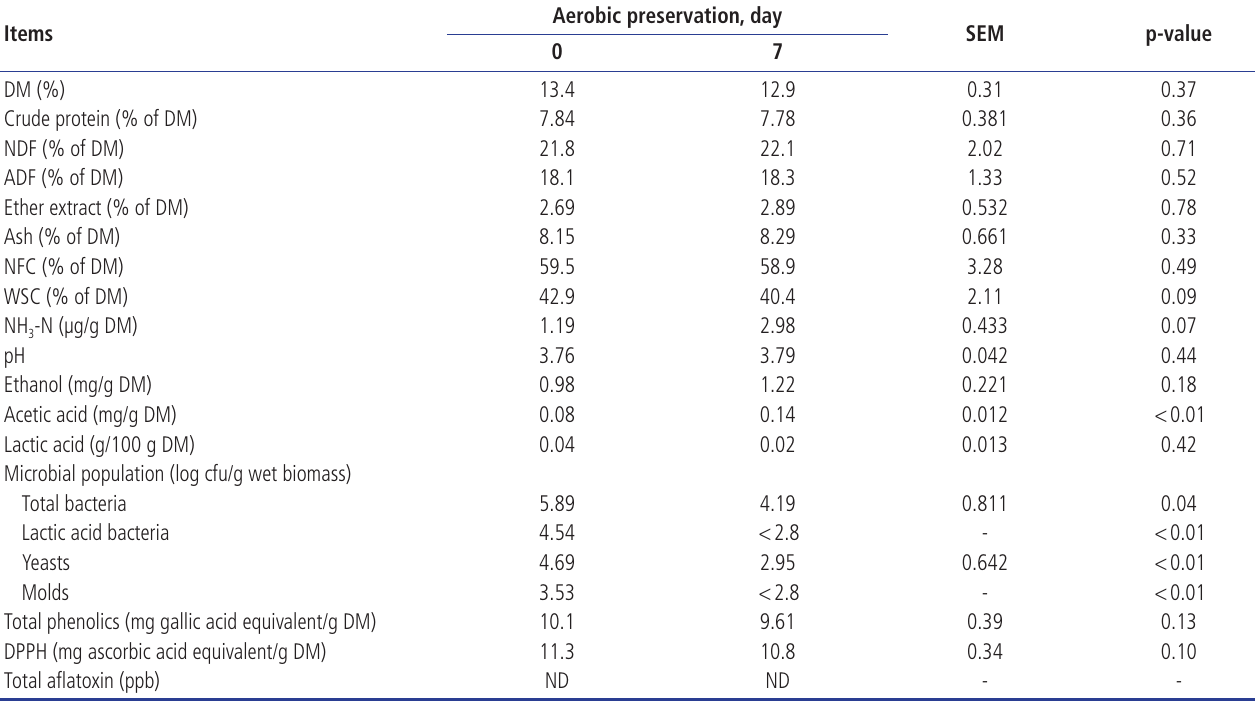
Aerobic preservation, day